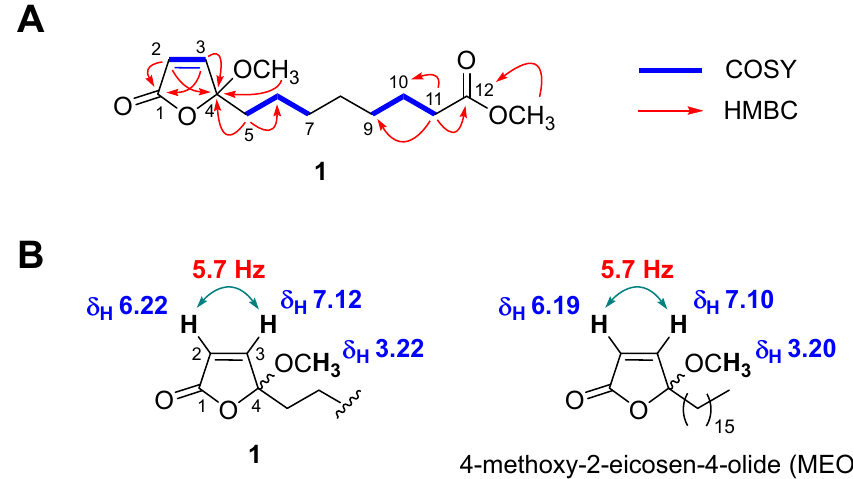
Figure 2. Structure elucidation of 1 . ( A ) Key COSY and HMBC correlation of 1 . ( B ) Comparison of the key 1 H NMR data around the UBL functionality in 1 (left) and its structurally similar marine metabolite MEO (right).